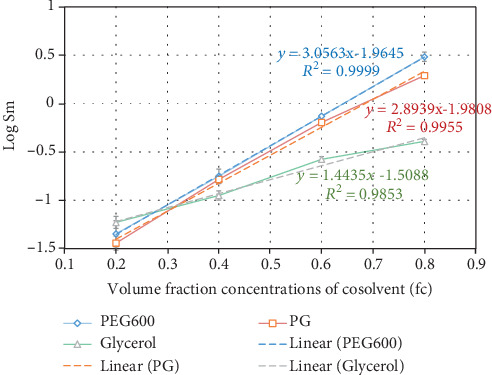
Log-linear solubilization plot of CXB in different cosolvent mixtures (mean ± SD, n = 3).